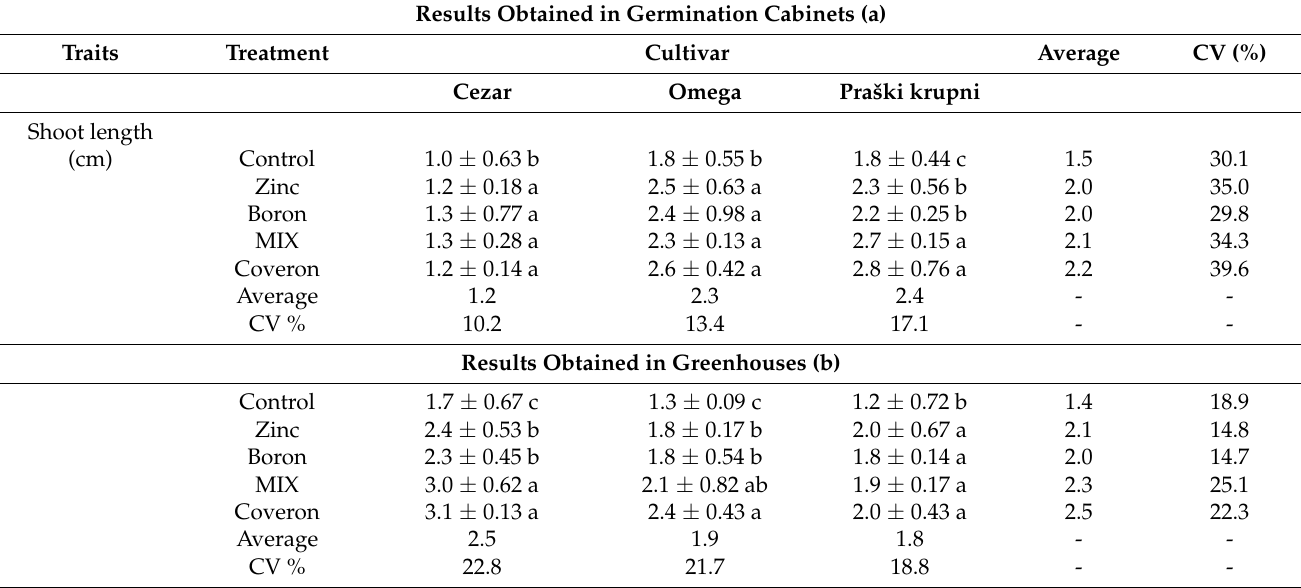
Table 6. Growth of shoot length after treatments applied to celeriac cultivars. Results Obtained in Germination Cabinets